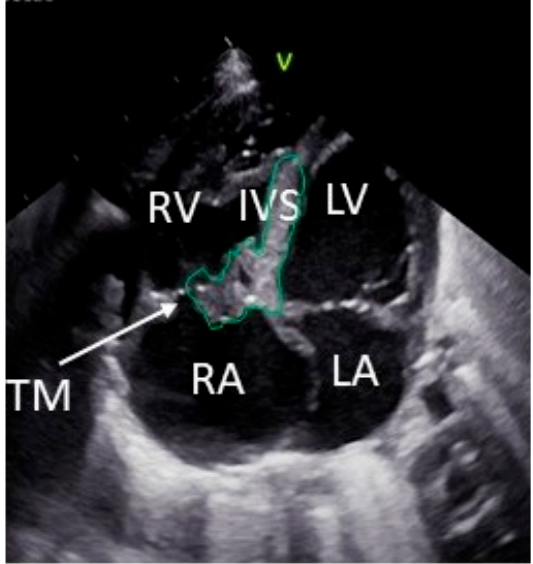
Figure 3. Echocardiografic four-chamber view at date of birth showing reduction in the right ventricular tumor size (tumor circumference in green). IVS: interventricular septum; LA: left atrium; LV: left ventricle; RA: right atrium; RV: right ventricle; TM: tumor. Because of asymptomatic ventricular preexcitation, betablocker therapy (metoprolol tartrate 0.1 mg/mL solution; in-house production) was also started. After a further eight weeks, the right atrial tumor disappeared, as well as the left ventricular posterior wall rhabdomyoma. In the intraventricular septum, the size of the tumor decreased from 82% to 35%, measured as the ratio of the largest tumor size (LTS)/right ventricular diameter + LTS in the four-chamber view (Figure 4).